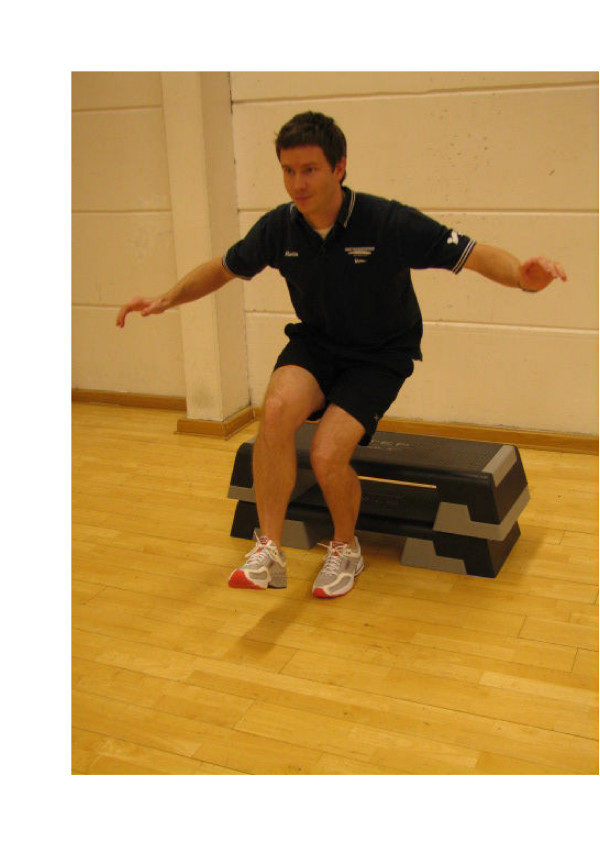
Rising up and sitting down on one leg.